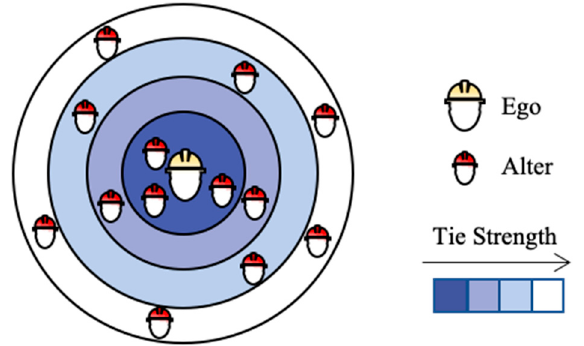
Figure 1. Ego network structure.